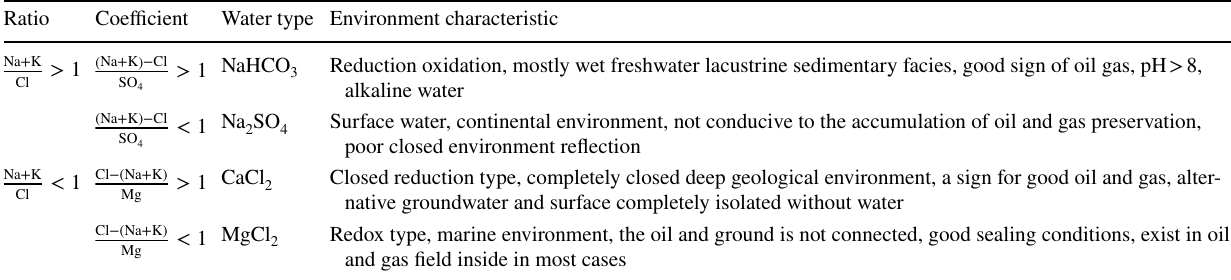
Table 3 Environment characteristic and water type depending Sulin coefficient Ratio Coefficient